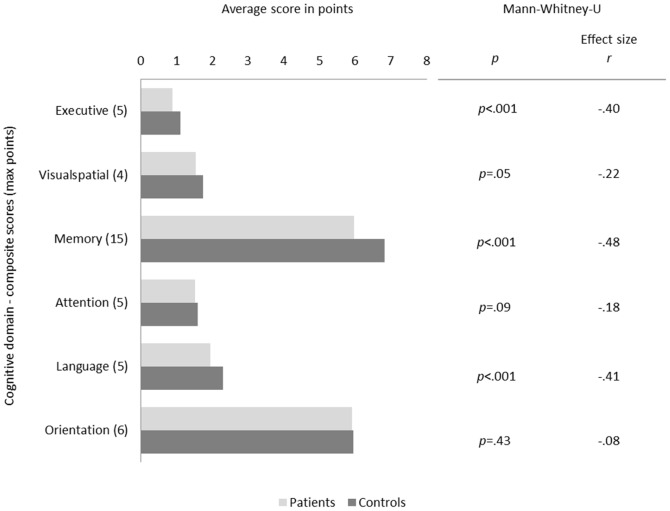
Group differences in cognitive domain composite scores of the Montreal Cognitive Assessment.The bar chart in figure 1 displays the average points scored by the patient and control group for each of the cognitive domains of the Montreal Cognitive Assessment (MoCA). The group differences were assessed using the non-parametric Mann-Whitney-U test with respective p-values showing a significantly (p≤.001) poorer performance of the patient group in the domains of executive functions, episodic memory and language. Notes. *Executive: Trail Making Test (TMT) B, verbal abstraction, digit span backwards, phonemic word fluency; Visuospatial: cube copying, clock drawing; Memory: immediate and delayed word recall; Attention: digit span forwards, letter cancelation, number subtraction; Language: sentence repetition, animal naming; Orientation: temporal and spatial orientation. Group differences were assessed using the Mann-Whitney-U test with a significance level of p≤.001.